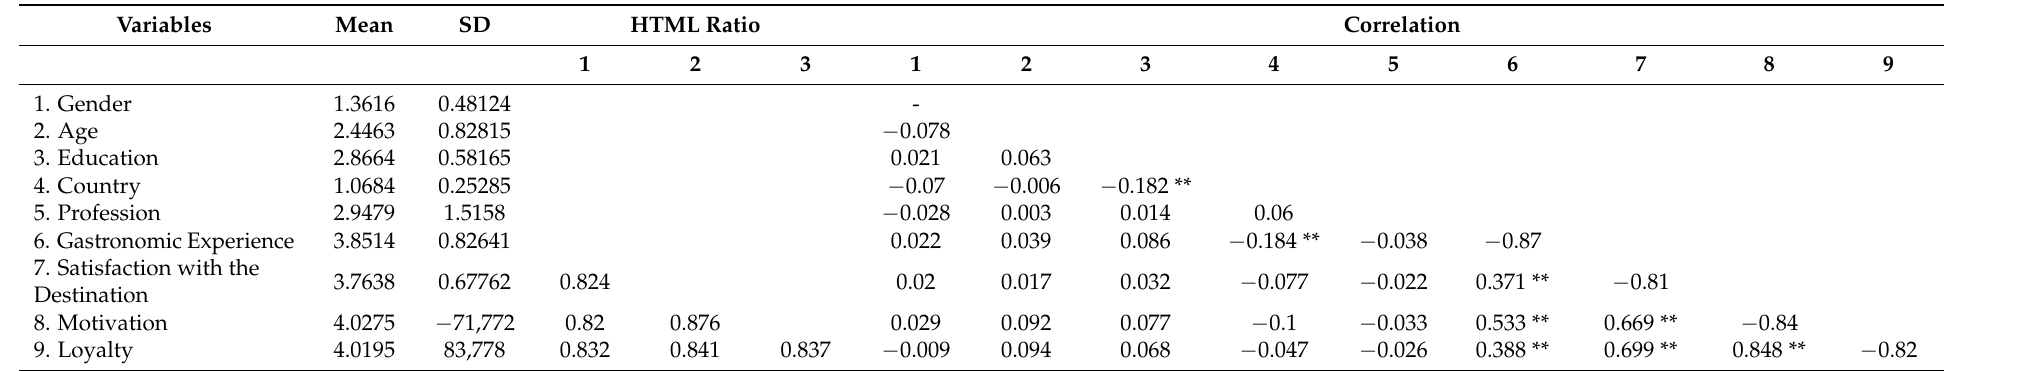
Table 2. Correlation, Mean, SD, Reliability and HTML